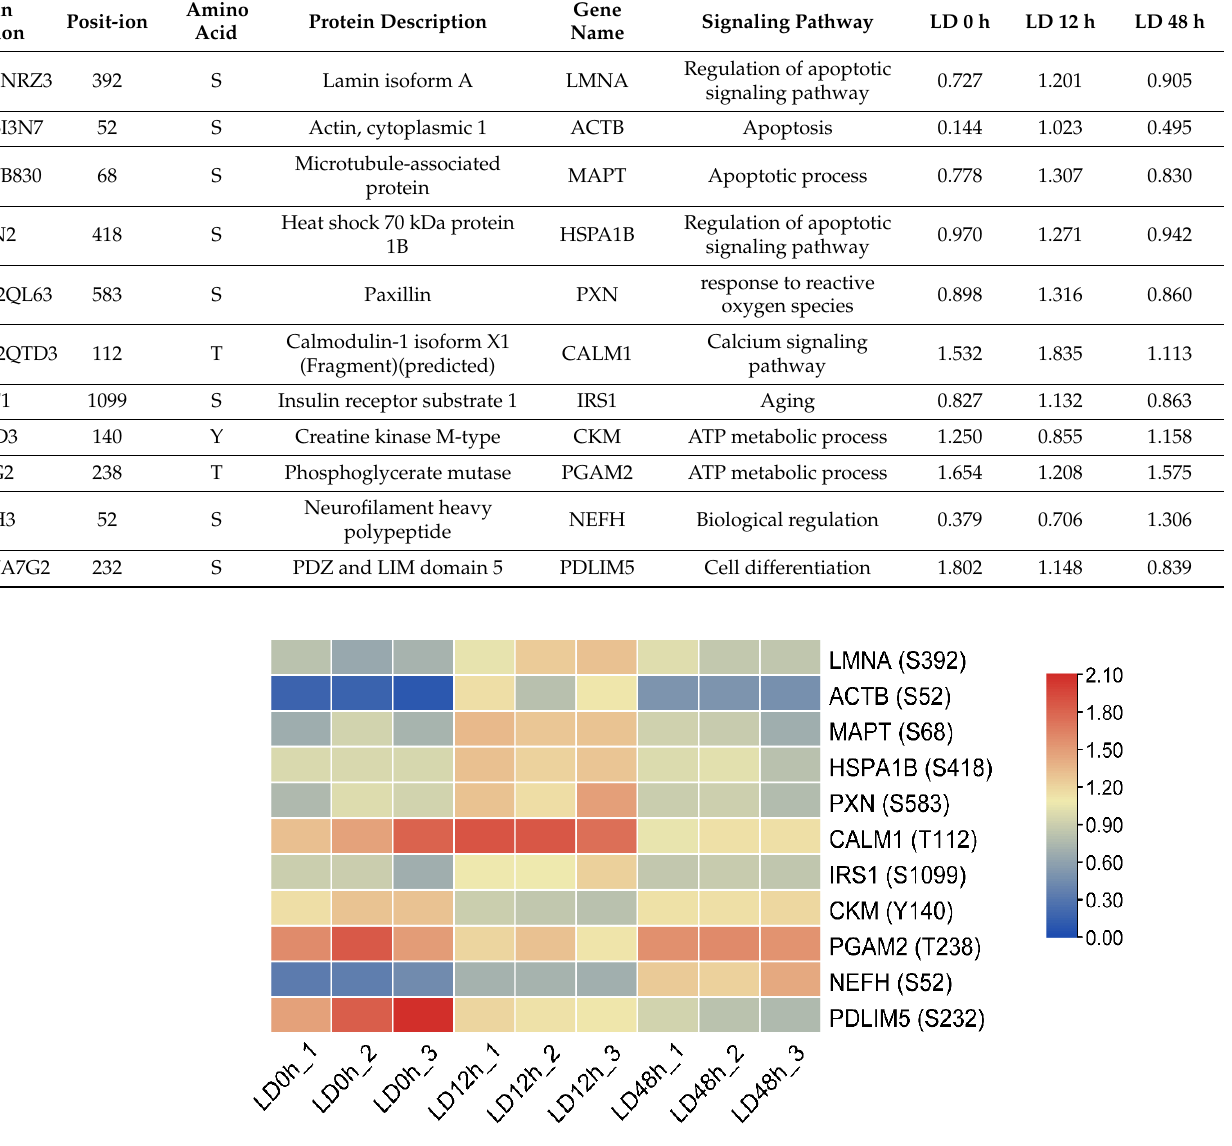
Figure 5. Heatmaps of interacting differentially expressed proteins in postmortem pork muscle. The shade of red and blue represents high expression and low expression, respectively.